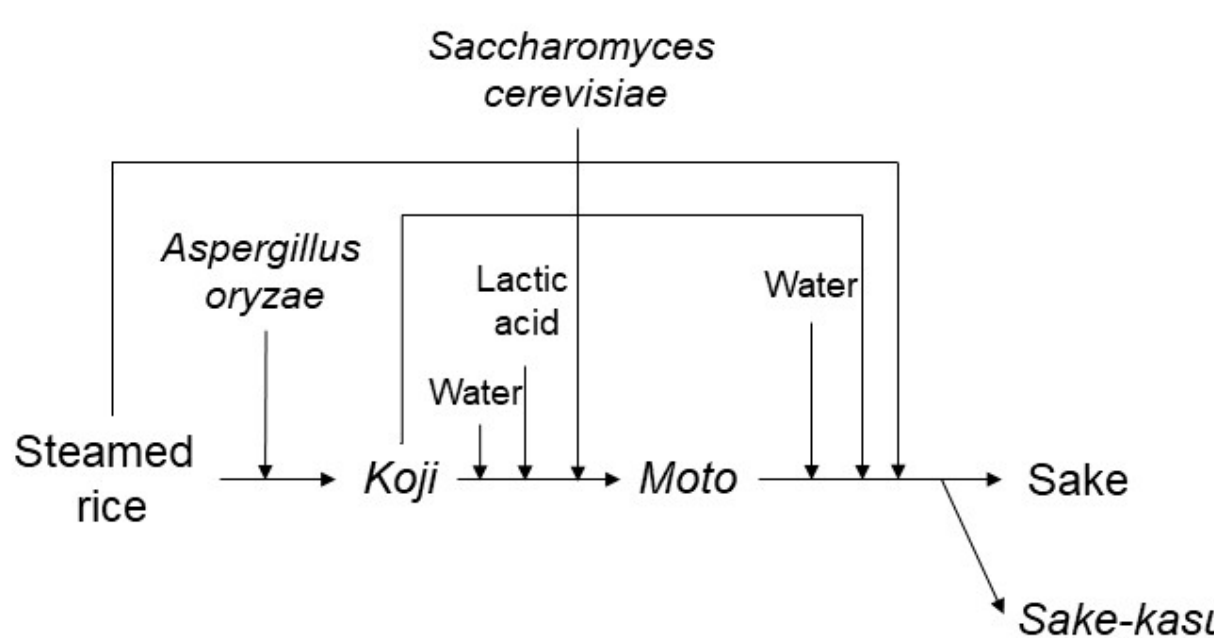
Figure 1. Sake production scheme. Koji is a mixture of steamed rice and Aspergillus oryzae . Moto is an ethanol fermentation starter. Sake and sake-kasu are separated by filtration.